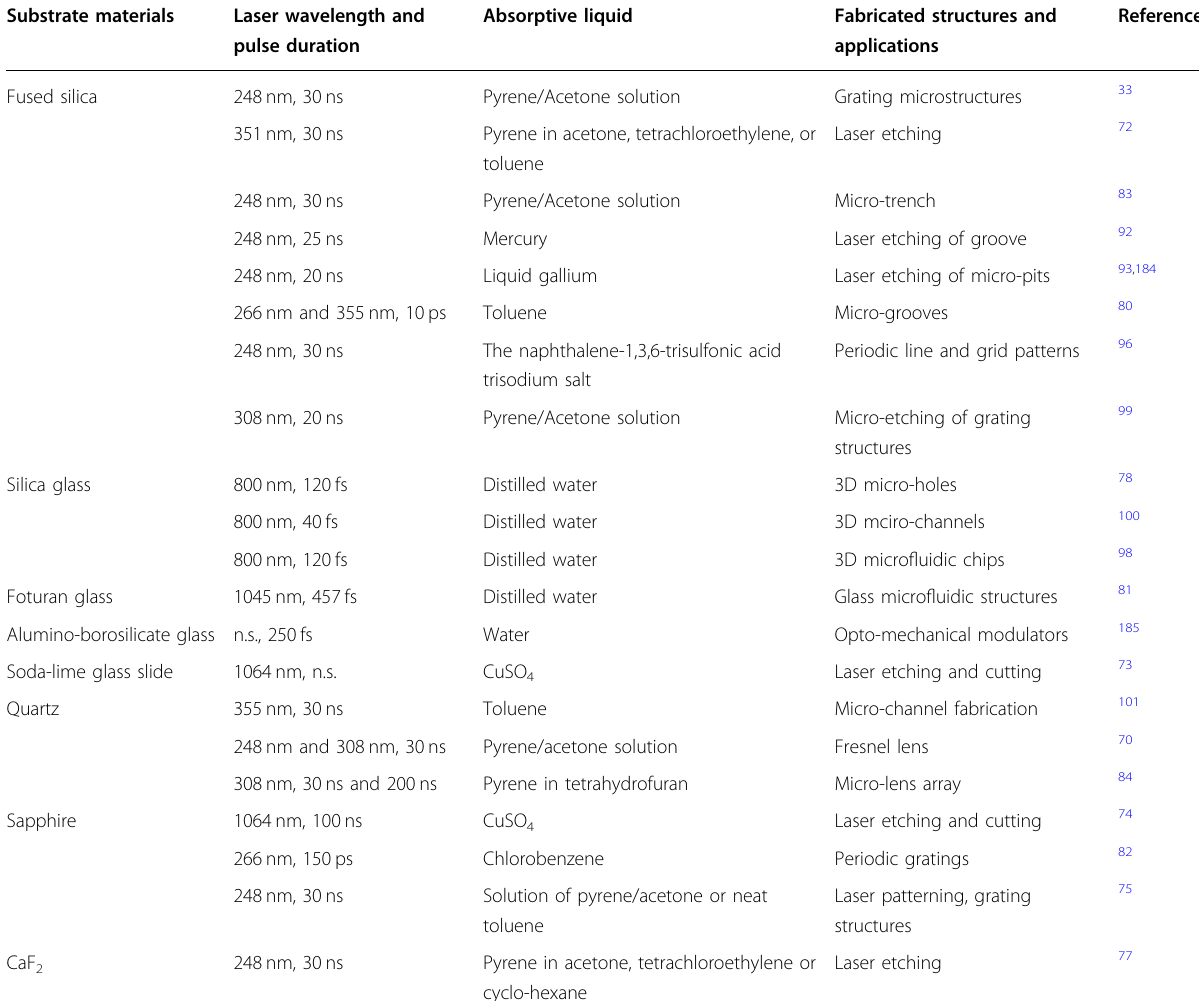
Table 2 Summary of LIBWE studies on different transparent hard materials Substrate